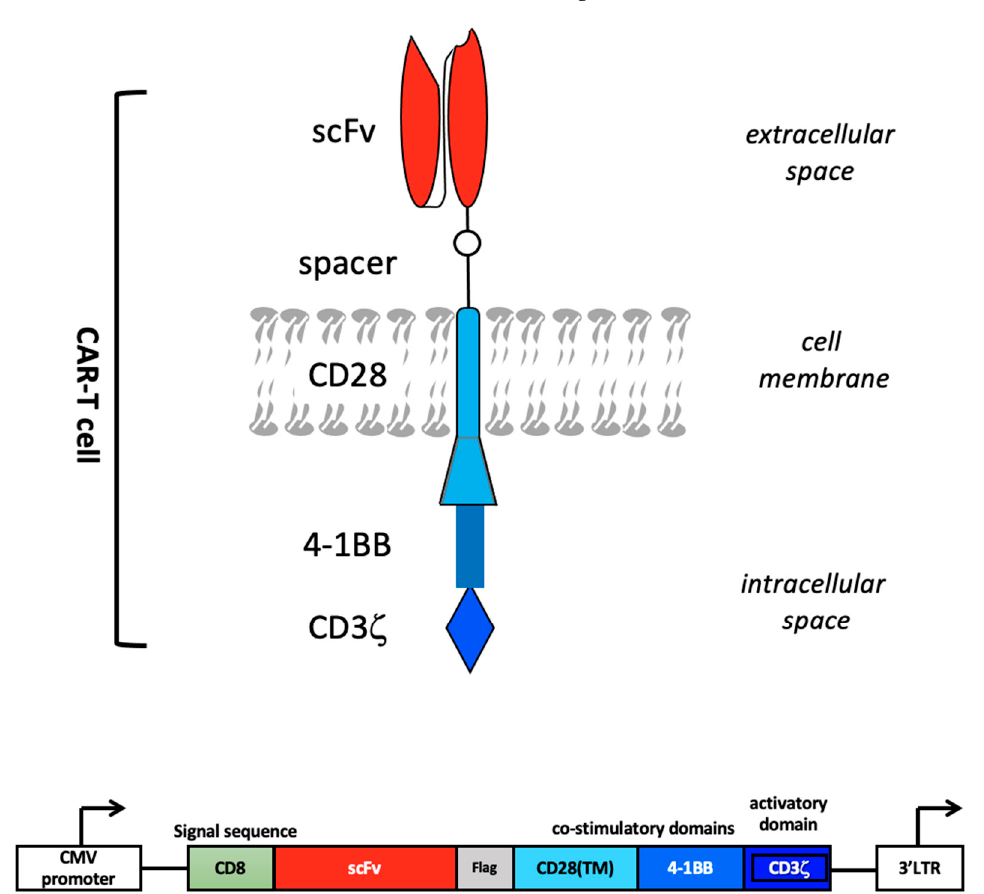
Figure 2. CAR design. The extracellular portion of the CAR molecule is typically derived from a monoclonal antibody that recognizes a cancer-associated antigen. The variable heavy (VH) and light (VL) chains, or single-chain variable fragment (scFv), are connected by a hinge to form the antigen- binding region of the CAR molecule. The antigen-binding region is linked through a transmembrane domain to an intracellular T-cell signaling domain, in particular CD3 ζ , which is the primary activation domain for TCR mediated T-cell activation. A CAR construct further comprises one or more co-stimulatory domains, e.g., those derived from 4-1BB and CD28. Bottom: schematic representation of a CAR construct inserted in an expression vector, e.g., a lentiviral vector. Vector-derived CMV (cytomegalovirus)-promoter and 3 ′ LTR (long terminal repeat) regions are depicted.